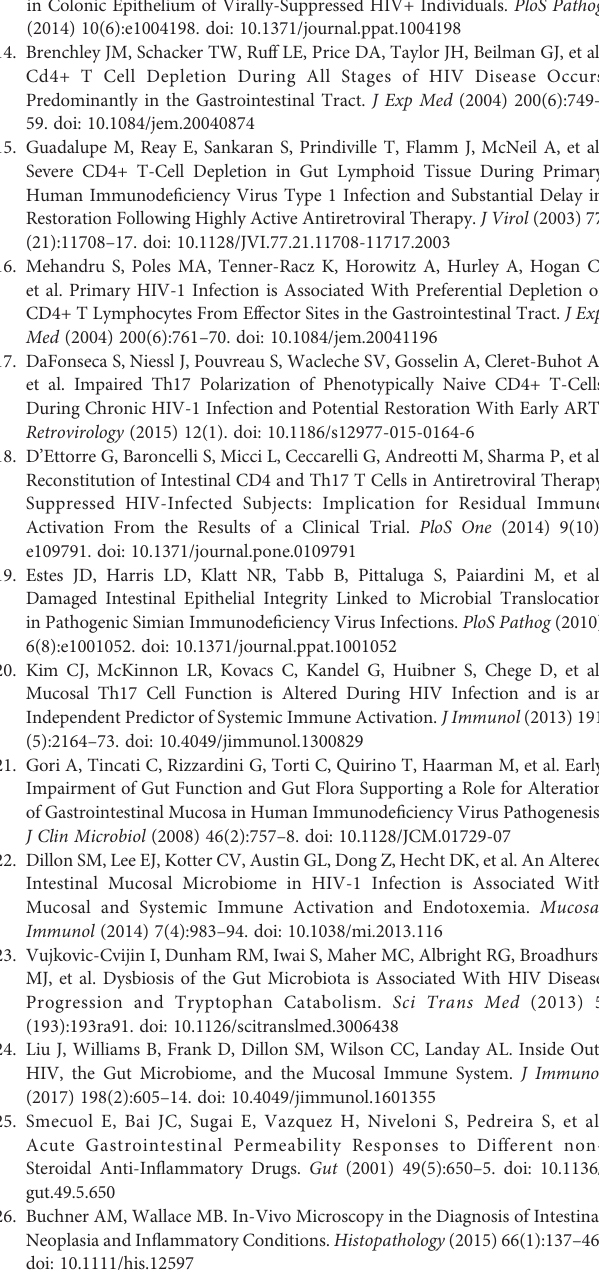
respectively, were analysed for CD103 expression. (B) – Top row: Gating of CD45+ SSC low lymphocytes, then CD3+ and CD20-negative, then CD45RA- negative, then CD8 T-cells (CD3+ CD4 negative). -Bottom row: CD8 T cells then analysed for CD38 vs HLA-DR, and CD49d vs integrin ß7, and CD38+CD127 low cells. -Then CD38+HLA-DR+ cells were analysed for CD49d vs integrin ß7 expression Supplementary Figure 2 | Activated CD38+CD127 low CD8 T-cells in blood and tissues. Activated CD38+CD127 low as % of CD45RA- CD8 T cells in peripheral blood, and in TI and LC biopsies, by study group. HUC: HIV-uninfected controls, PHI: HIV-positive patients treated during primary infection, CHI: HIV-positive patients treated during chronic